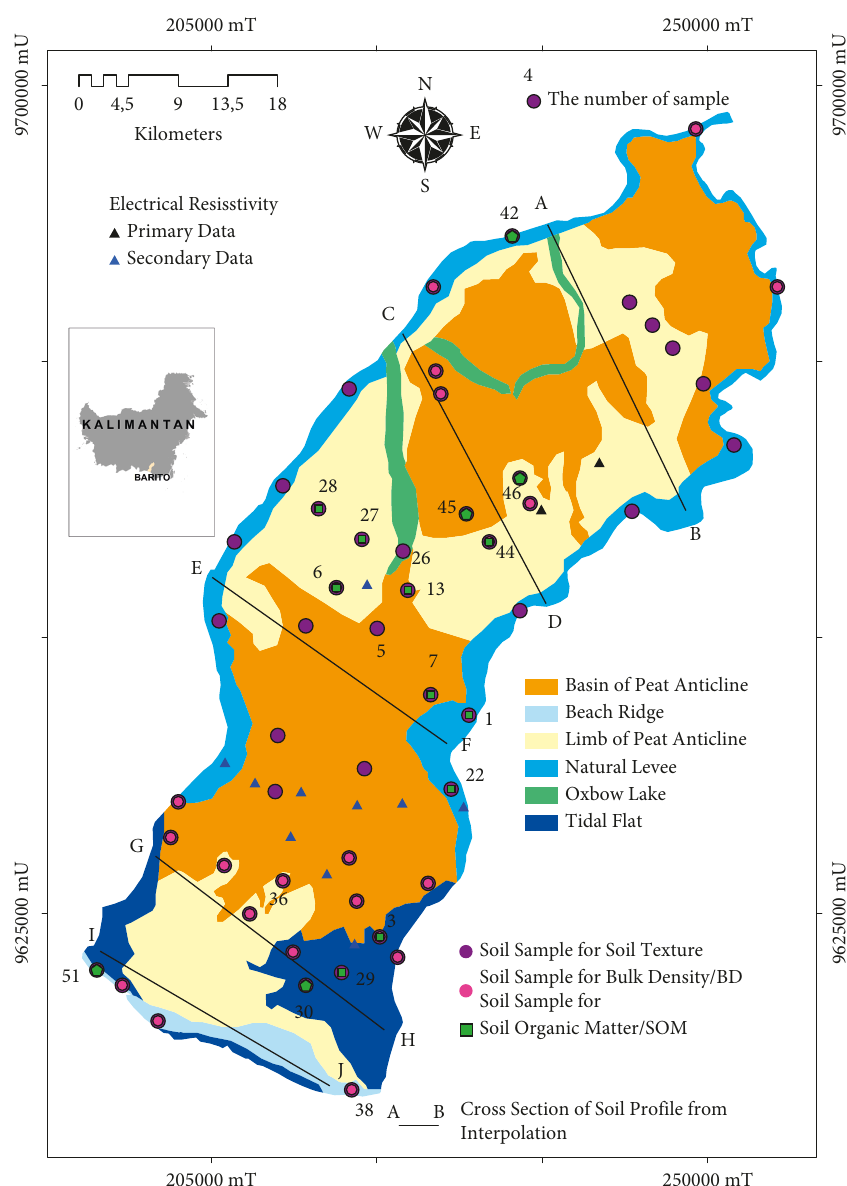
Figure 1: Location of soil samples and electrical resistivity measurement in landform of Barito Delta (source: modification of Arisanty [37]). The location of cross-section to describe in detail soil texture characteristics from